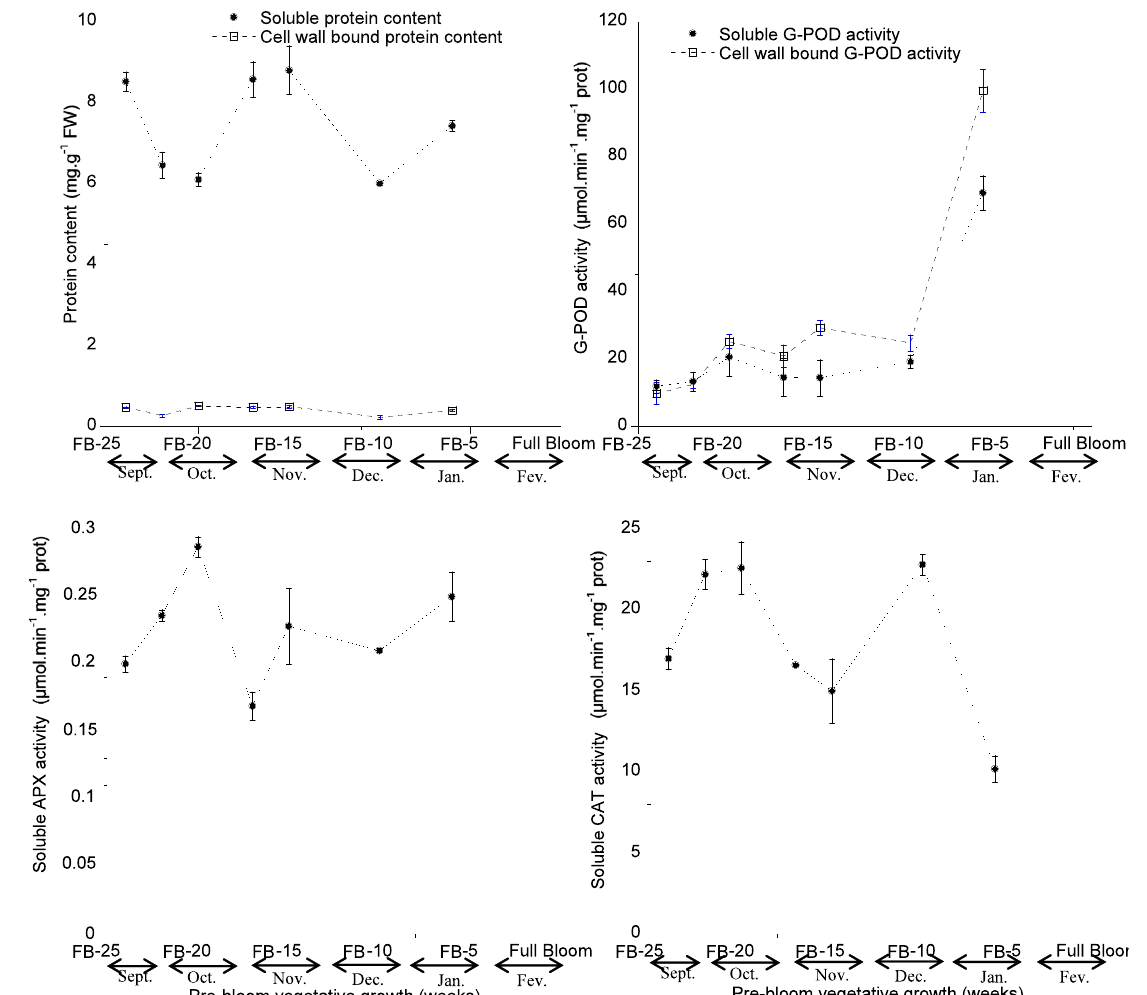
Fig. 1: Changes in biochemical parameters in younger fully expanded leaves sampled on one-year-old woody twigs bearing both leaves and future flower buds (mixed-type inflorescences) from 4-year-old lemon trees. Total soluble and cell-wall bound (CWB) proteins, and G-POD, APX and CAT specific activities and CWB G-POD specific activities were characterized during the winter resting period from September to January (release of flower bud dormancy). The sample dates reported on the x-axis are also converted into “weeks before Full Bloom (FB, end of February)”. Bars indicate the stan- dard error (mean+/- S.E.,